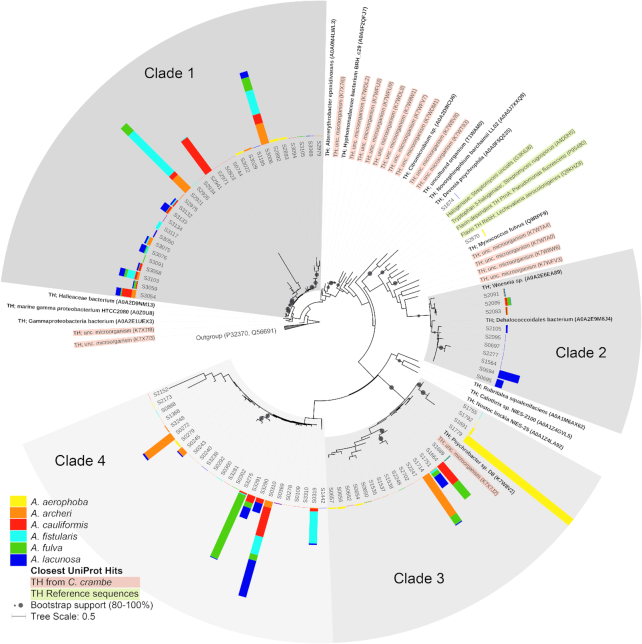
Maximum likelihood phylogeny of putative tryptophan halogenase (TH) protein sequences from six Aplysina species. Sequences obtained in this study are labelled with S. The tree was constructed from 247 amino acid positions. Two NADH-dependent flavin oxidoreductases (P32370 from Clostridium scindens and Q56691 from Vibrio harveyi) were used as outgroup. Four well-studied TH obtained from UniProt (green) and putative TH from the sponge Crambe crambe (pink) are included as reference sequences. Bars indicate relative abundance of the sequences in the sponge species, with the outer rim of the grey shading indicating 88%. Bootstrap values >80% are indicated by grey circles at the branch points. Sequences in bold refer to the closest relatives from the ‘halogenase’ database. UniProt sequence accession numbers are given inside brackets. Tree scale corresponds to the mean expected number of amino acid substitutions per site.